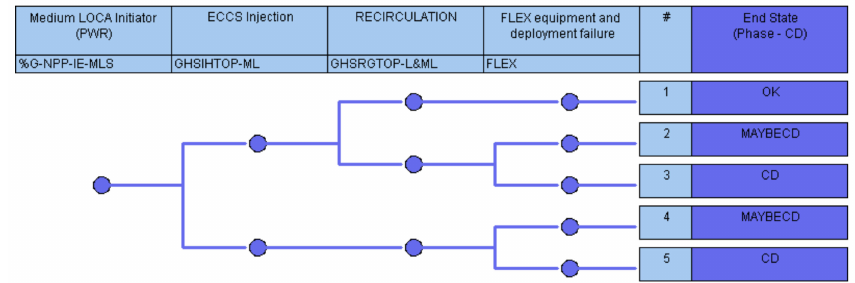
Figure 7. Event tree for medium break LOCA